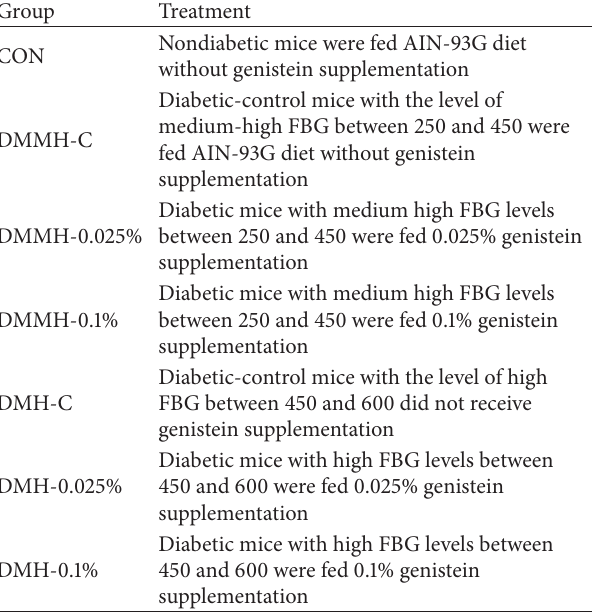
Table 1: Classification of experimental